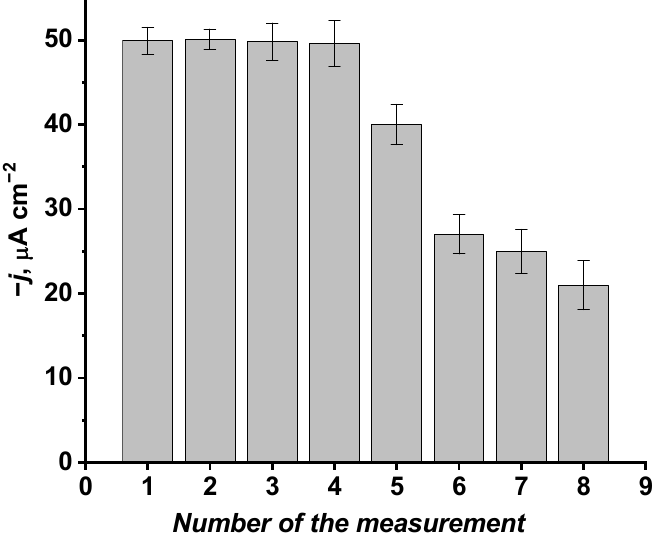
Figure 5. Chronoamperometric investigations performed with the same glass|FTO|PB electrode in 50 µ mol L − 1 of FCL-containing PBS. During chronoamperometric investigations 0 V vs. Ag|AgCl, KCl sat. potential was applied to the glass|FTO|PB sensor.